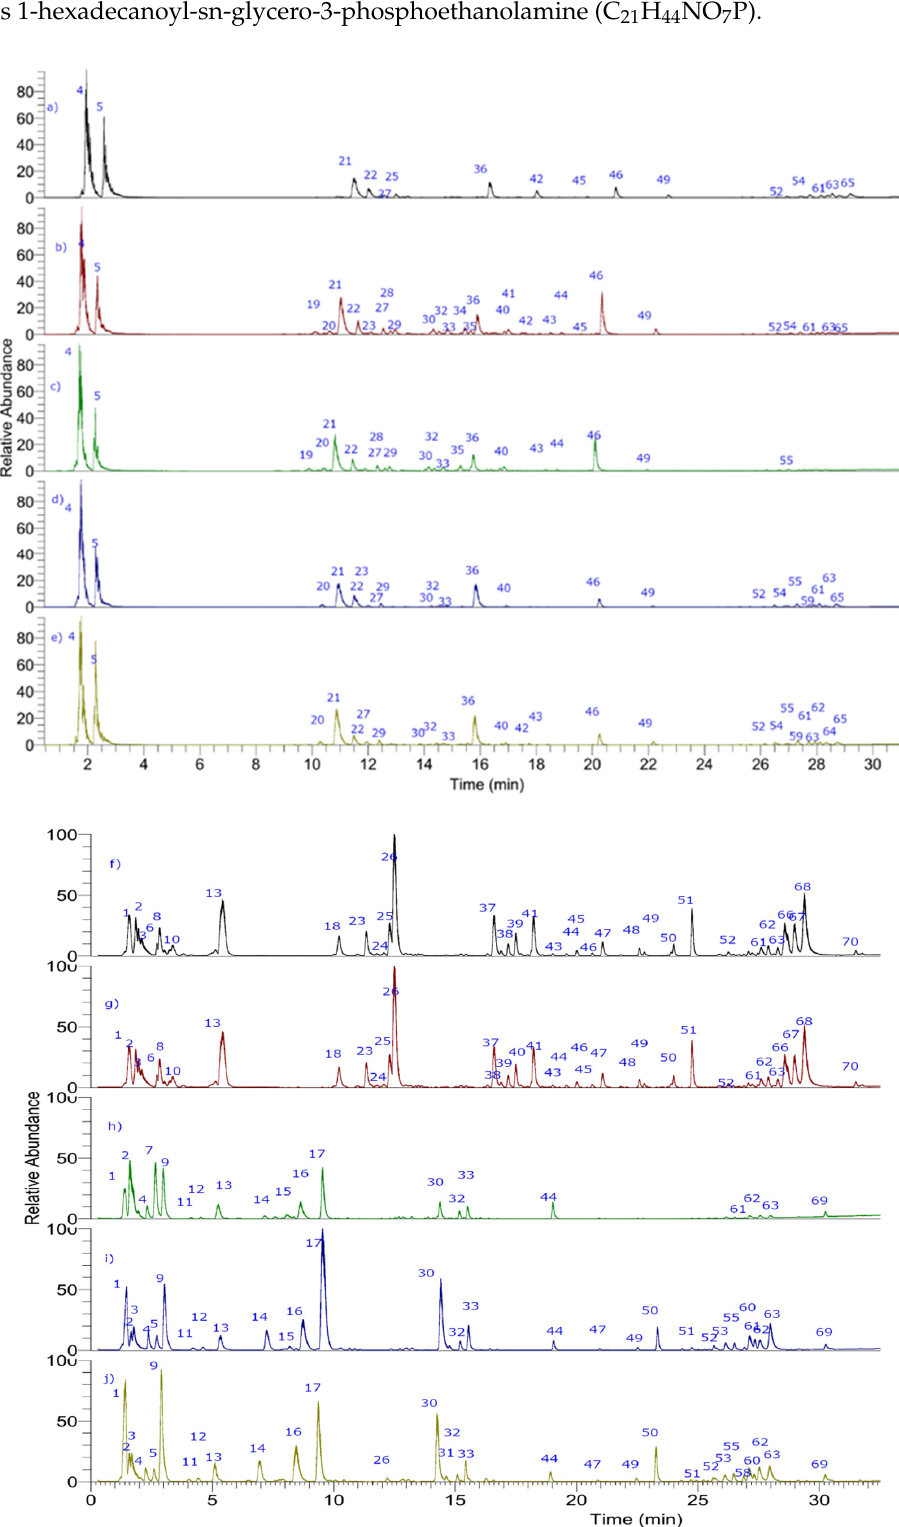
Figure 2. UHPLC-PDA-ESI-OT-MS chromatograms (TIC, total ion current) of cocona fruits NMA1, Figure 2. UHPLC ‐ PDA ‐ ESI ‐ OT ‐ MS chromatograms (TIC, total ion current) of cocona fruits NMA1, SRN9, CD1, CTR, SRN9, CD1, CTR, UNT2 ecotypes: ( a – e ) positive mode and ( f – j ) negative UNT2 ecotypes: ( a – e ) positive mode and ( f – j ) negative mode.